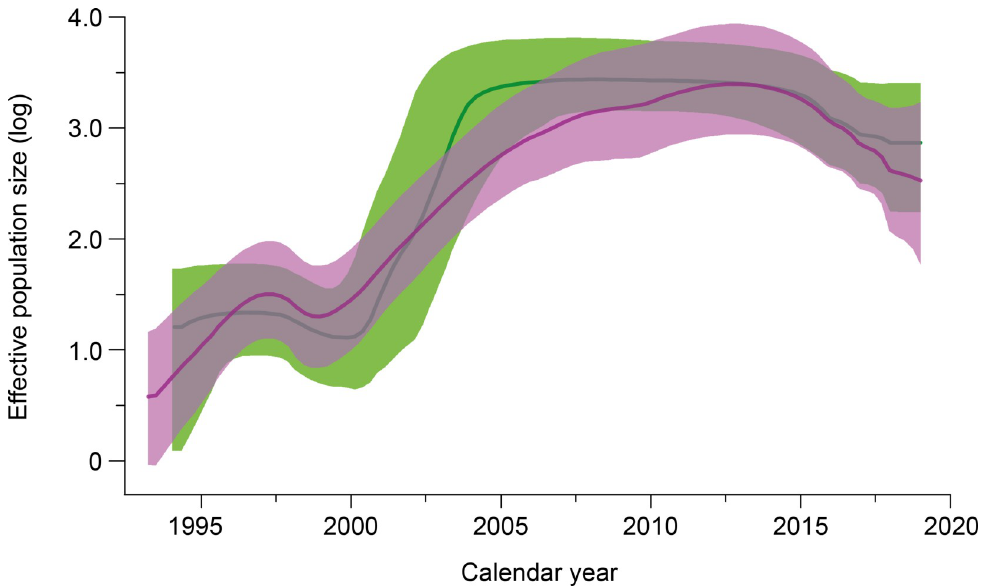
Fig 4. Demographic history of the HIV-1 CRF03_AB recombinant in the former Soviet Union. Estimates of the effective population size (Ne) through time (t) using Bayesian Skyline (green) and Bayesian GMRF (violet) coalescent model are presented on a logarithmic scale as median (solid color line) with the corresponding 95% HPD credibility interval (color area).